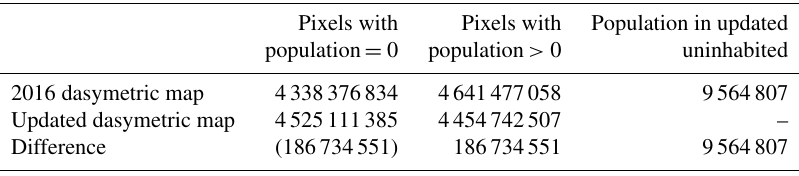
Table 5. Census block error for CONUS after applying block-level representative population density for each ancillary class to census tracts and ensuring pycnophylactic integrity at the tract level.